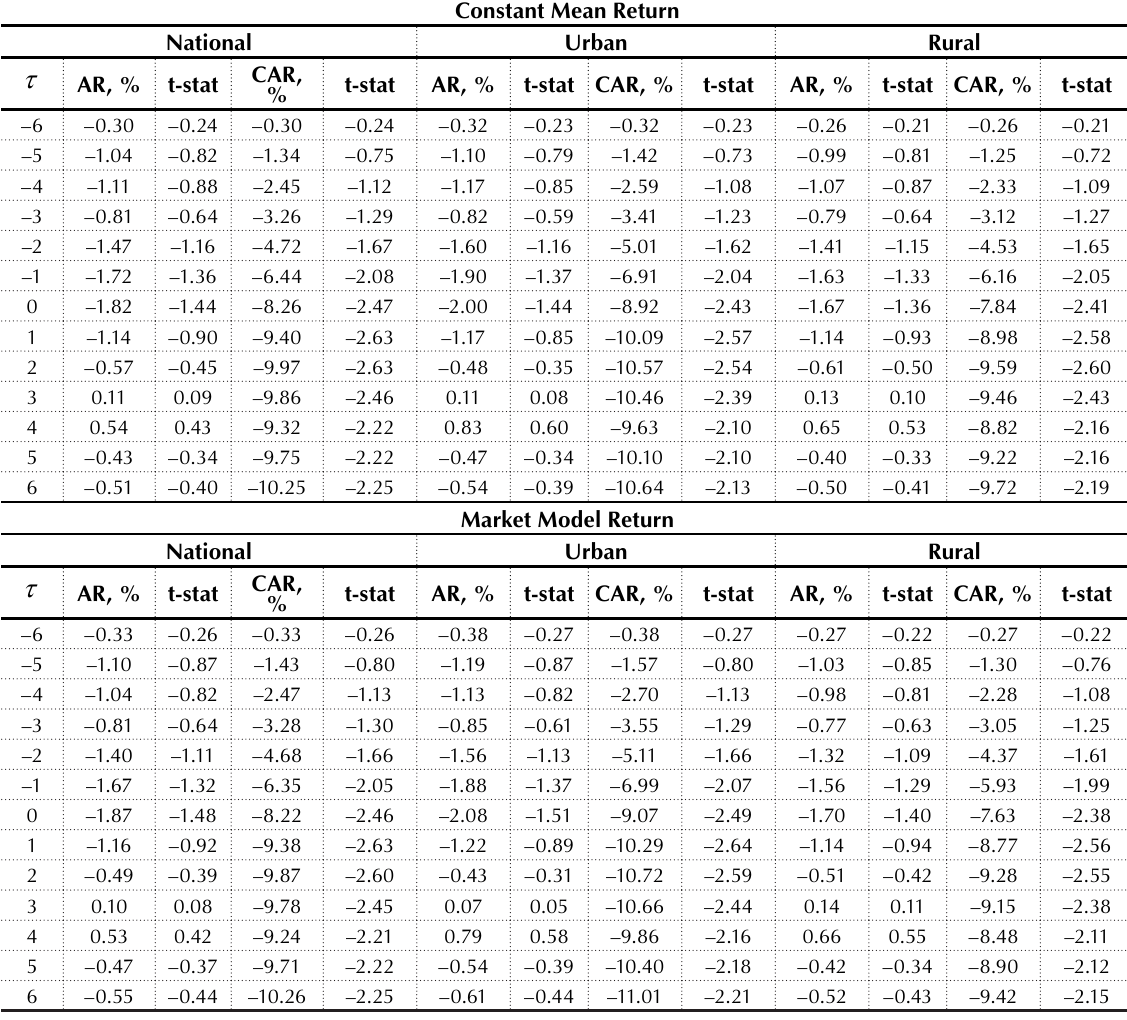
Table 3. Effect of the modification to personal income tax law on housing price